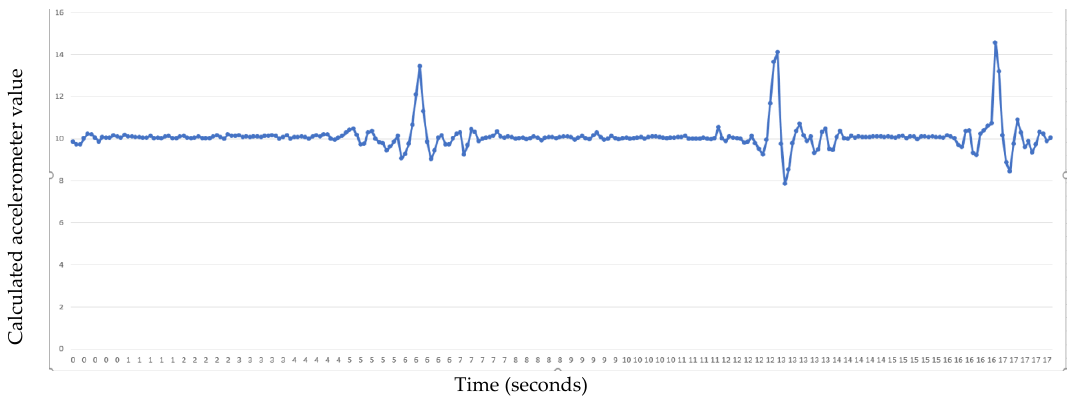
Figure 7. Calculated sum of squared values of accelerometer sensor coordinates (value = x 2 + y 2 + z 2 ) over time during three steps (represented by the graph peaks) with short rests in between. Sampling rate is five samples per second. Step pace and average step length over route sectors of known distance can be trivially calculated.